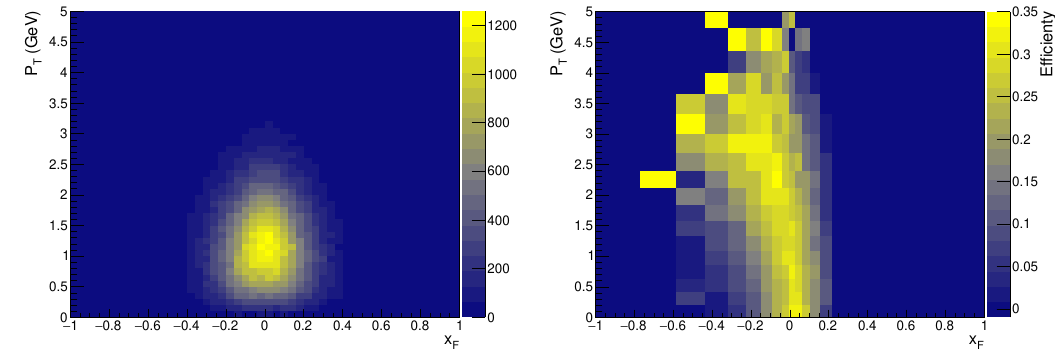
Figure 8 . The x F { p T distribution before the selection (left) and the estimated detection e(cid:14)ciency in the x F { p T plane (right).